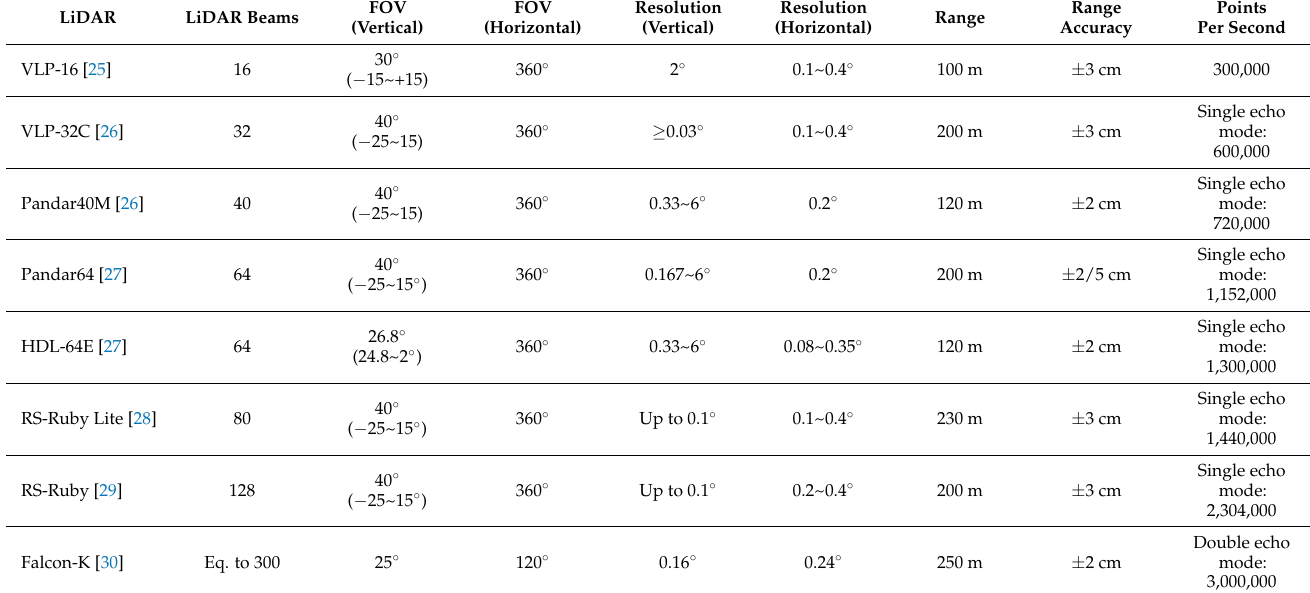
Table 1. Overview of typical LiDAR